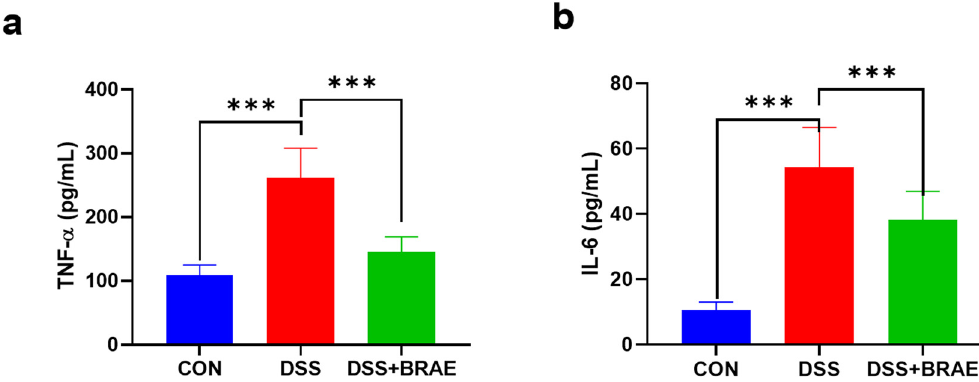
Figure 6: Serum concentrations of in fl ammatory cytokines TNF - α ( a ) and IL - 6 ( b ) . Data represent mean ± SD ( n = 10 ) , *** P < 0.001.